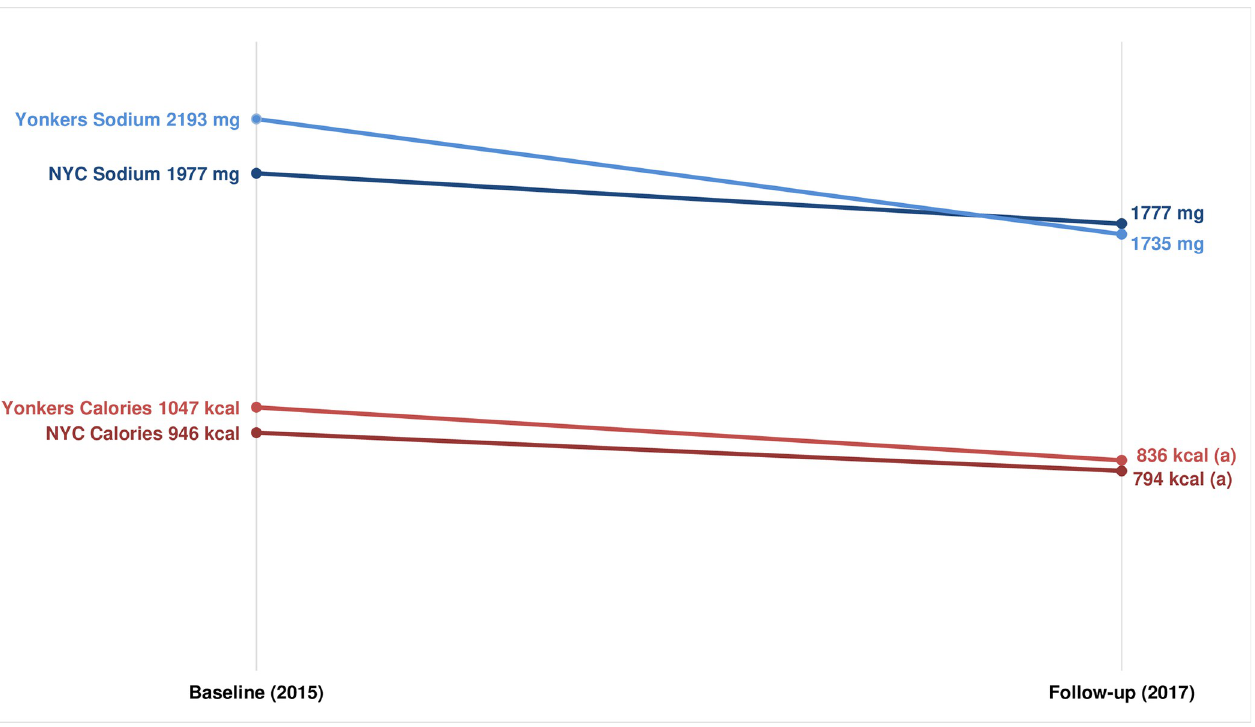
Fig 4. Mean sodium and calorie content * of lunchtime purchases at QSR chains, pre- (Baseline) and post-(Follow-up) implementation of the sodium warning icon in NYC. * Sodium and calorie values were square-root-transformed during analysis to meet model normality assumptions and to estimate differences (p values), but least-squared means estimates from models using non-transformed variables are presented for ease of interpretation. Full model estimates are shown in S5 Table in S1 File. a) 2015–16 vs 2017 p value < 0.05.